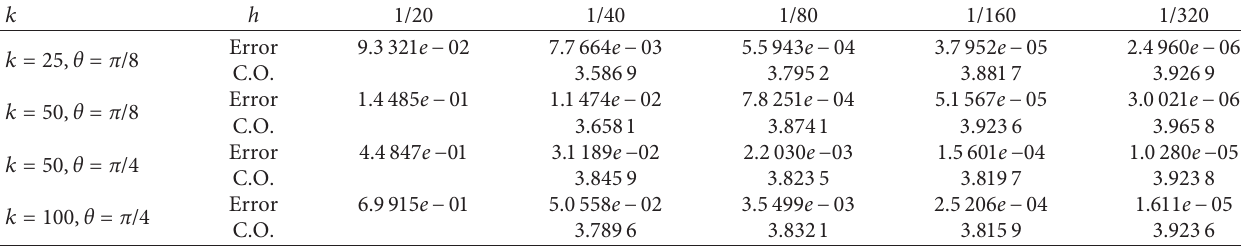
Table 3: Numerical convergence and error of the new 21-point difference scheme for Example 2.